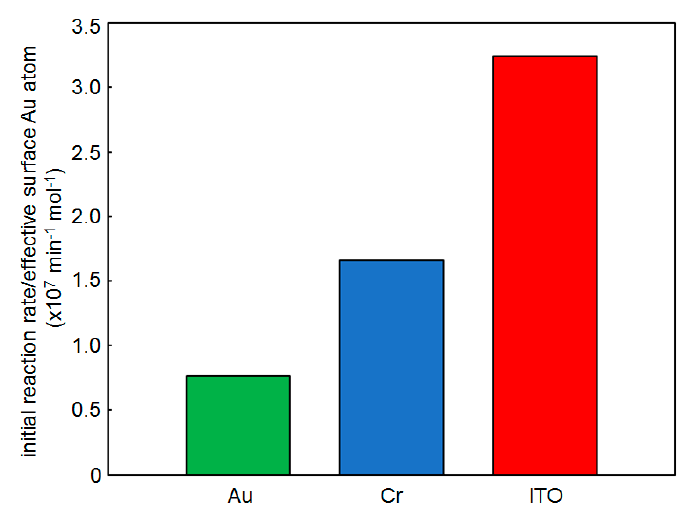
Figure 4. Catalytic activity of the 10Dod-array with different supports.